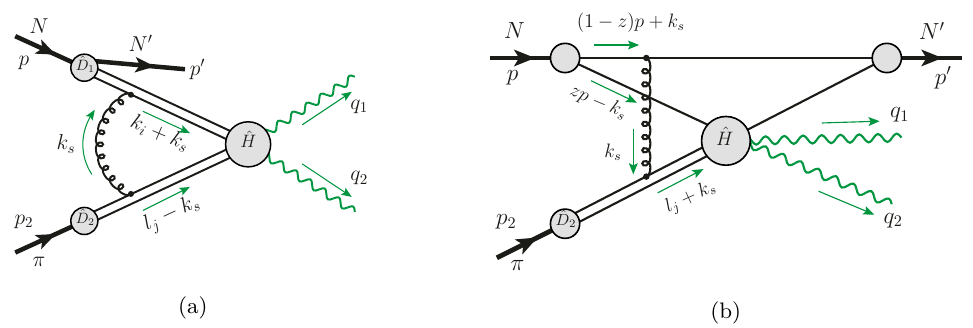
Figure 15. Difference in soft gluon interaction between ERBL region (a) and DGLAP region (b) in the elastic πN process. In (a), the k − is pinched to be in the Glauber